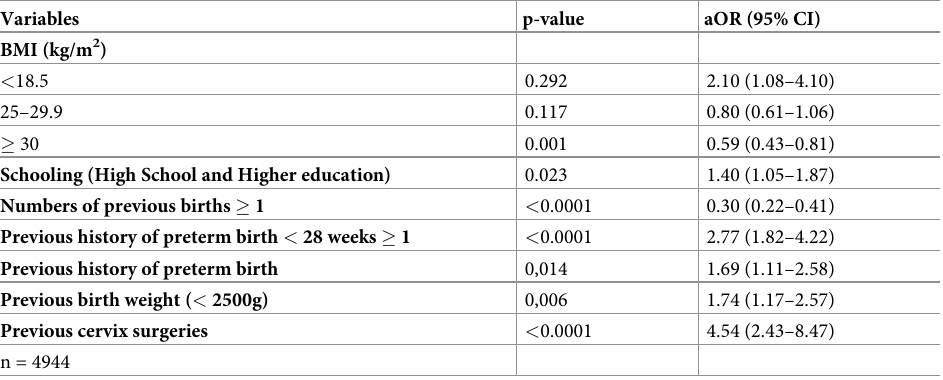
Table 4. Multiple analysis for cervical length � 25 mm in women with previous